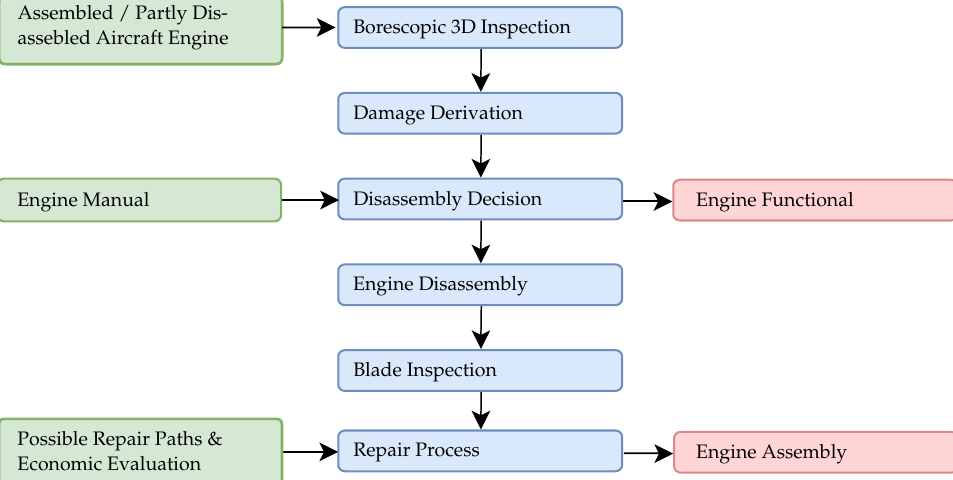
Figure 1. Workflow of the researched maintenance process with focus on the engine inspection and disassembly.